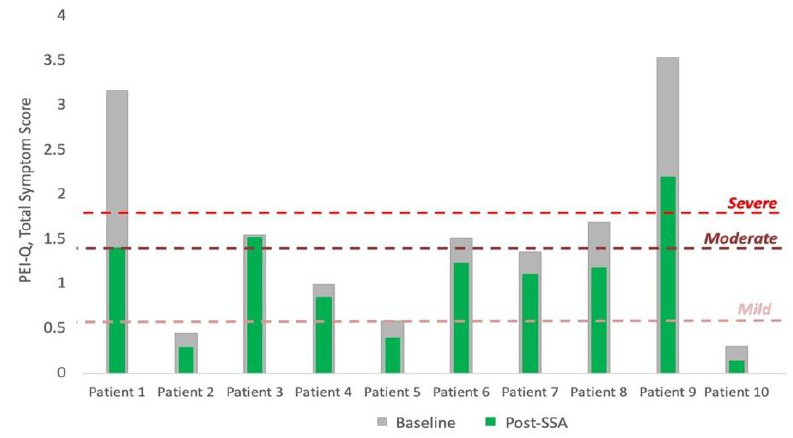
Figure 2. Bar graph of change in total symptom score of PEI-Q, where threshold for ‘mild’, ‘moderate’, and ‘severe’ PEI are at 0.6, 1.4, and 1.8 of total symptom score, respectively. Grey bars represent baseline scores and green bars the scores at 8 weeks (post-SSA).